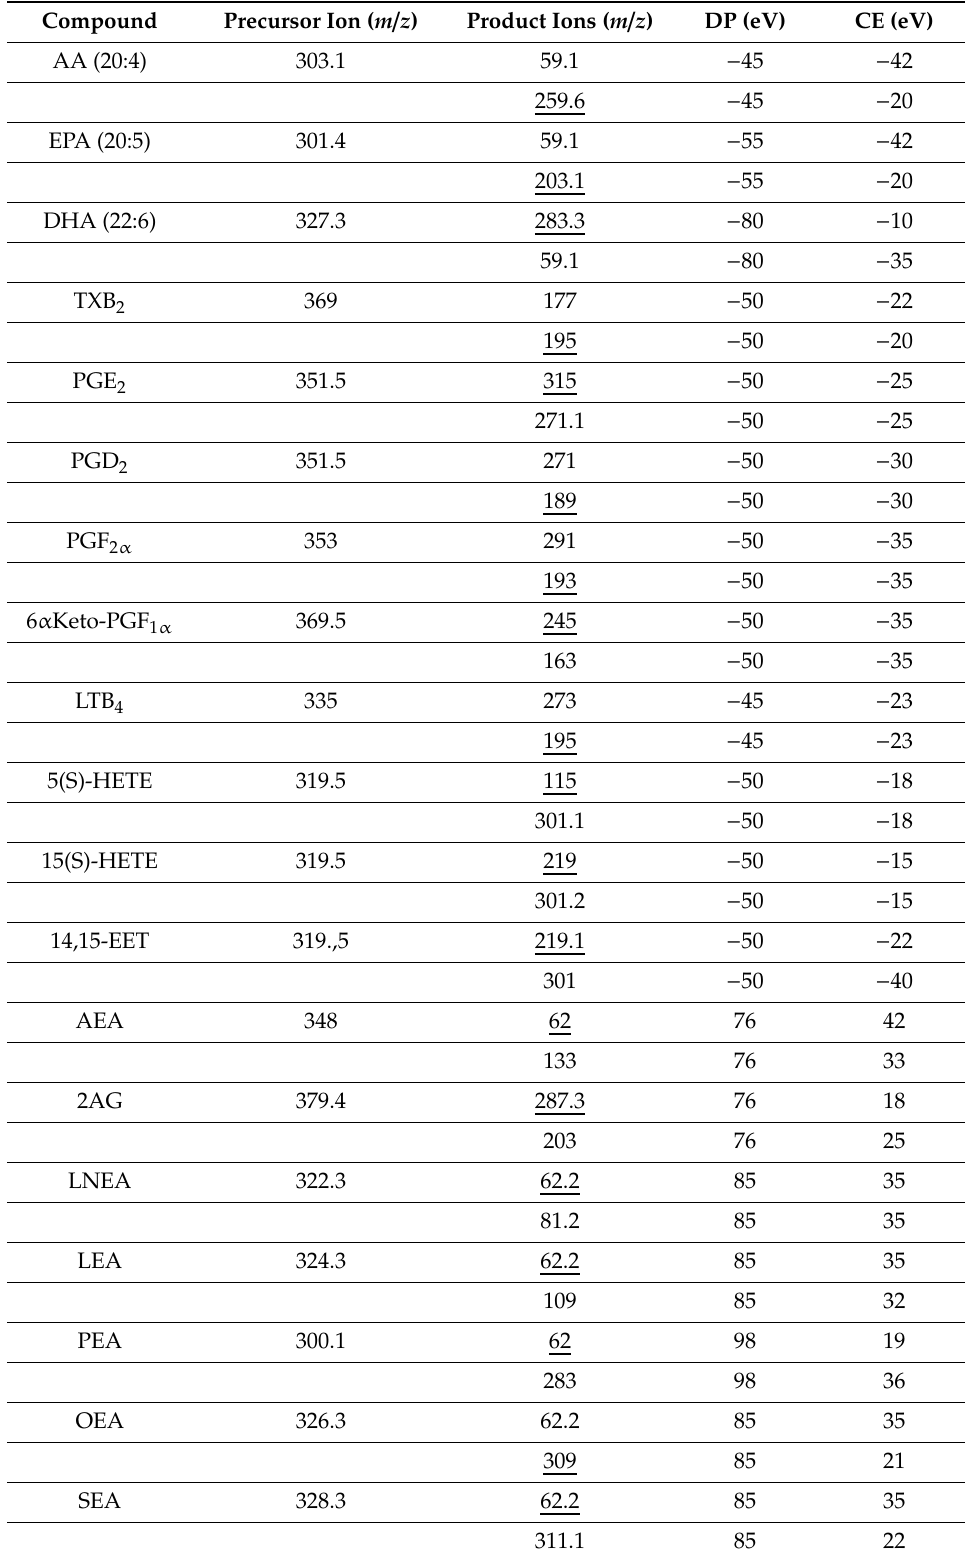
Table 1. Multiple reaction monitoring (MRM) parameters: precursor and product ion transitions (quantifier underlined) for all the analytes and internal standards (ISs), de-clustering potential (DP), and collision energy